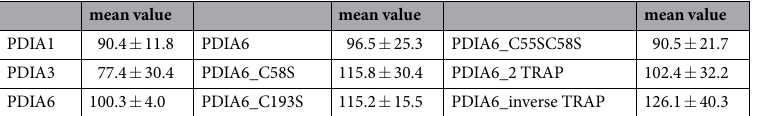
Table 1. Ellman’s tests confirmed the successful reduction of analysed PDIs. Upon DTT treatment and buffer exchanges, the percentage of reduced cysteine residues was tested by Ellman’s test. The concentrations of detected free disulfide groups were taken into the relation to the calculated concentration, which was taken from the protein concentration (measured by the absorption at 280 nm) multiplied by the numbers of cysteine residues in the individual PDIs. These concentrations were set to 100% of reduced cysteine residues. PDIA6 was tested in two experimental serials, ones together with PDIA1 and PDIA3, and ones with the indicated TRAP mutants. All tests were performed at least three times